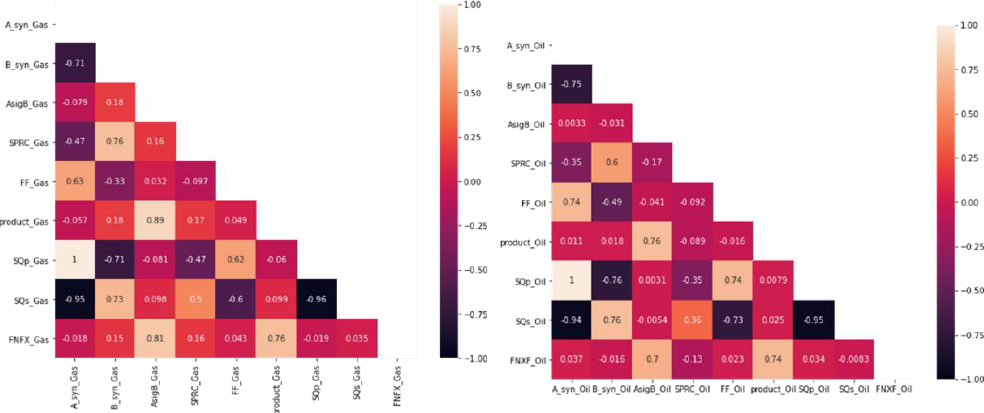
Figure 5. Heatmap correlation of SOM features map.